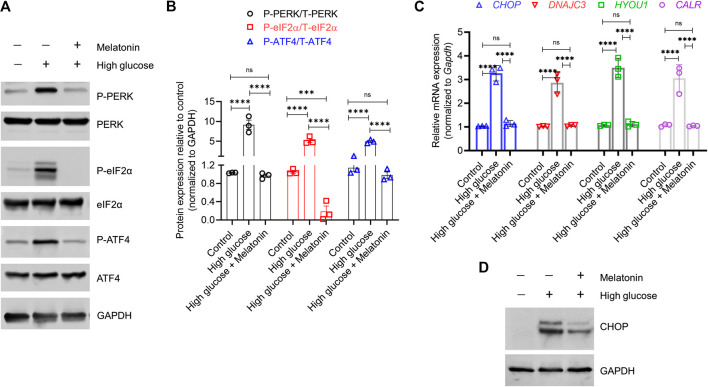
Melatonin reverses the activation of both proximal sensors and downstream effectors associated with high glucose-induced endoplasmic reticulum stress (A,B) Immunoblot analysis of phosphorylated and total PERK, eIF2α, and ATF4 proteins in the MC3T3-E1 cells grown under normal (control) and high glucose conditions for 48 h ± melatonin (100 nM) (A) The representative blots from three independent experiments and (B) the corresponding densitometry analysis are shown. GAPDH was used as a loading control (C) Relative mRNA expression of Chop, Dnajc3, Hyou1, and Calr in the MC3T3-E1 cells grown under normal (control) and high glucose conditions for 48 h ± melatonin (100 nM). The fold expression was calculated relative to the expression under control conditions. Gapdh was as used as a normalization control. (D) Representative immunoblot images of CHOP under the same conditions is shown. GAPDH was used as a loading control. These represent three independent experiments. For (B,C), bars are mean ± SEM. ***p < 0.001, ****p < 0.0001, ns: not significant.